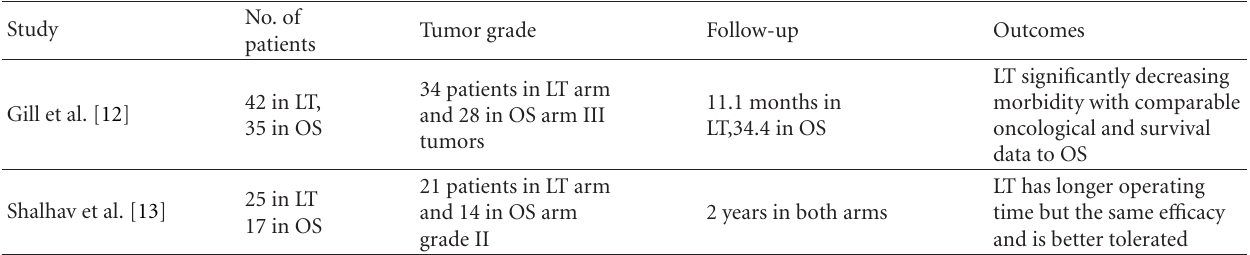
Table 1: Studies that compare laparoscopic nephroureterectomy with open